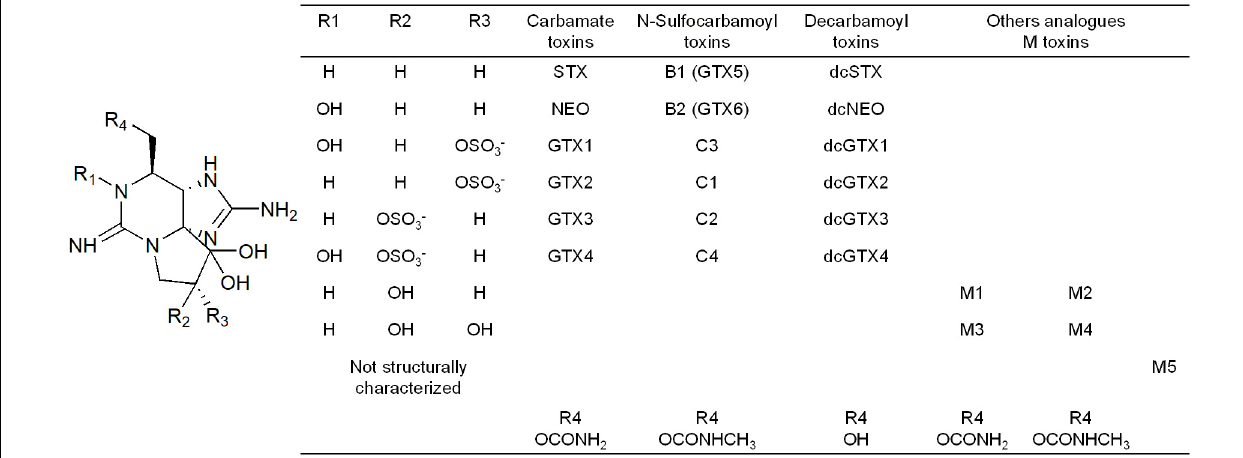
Frontiers in Marine Science |